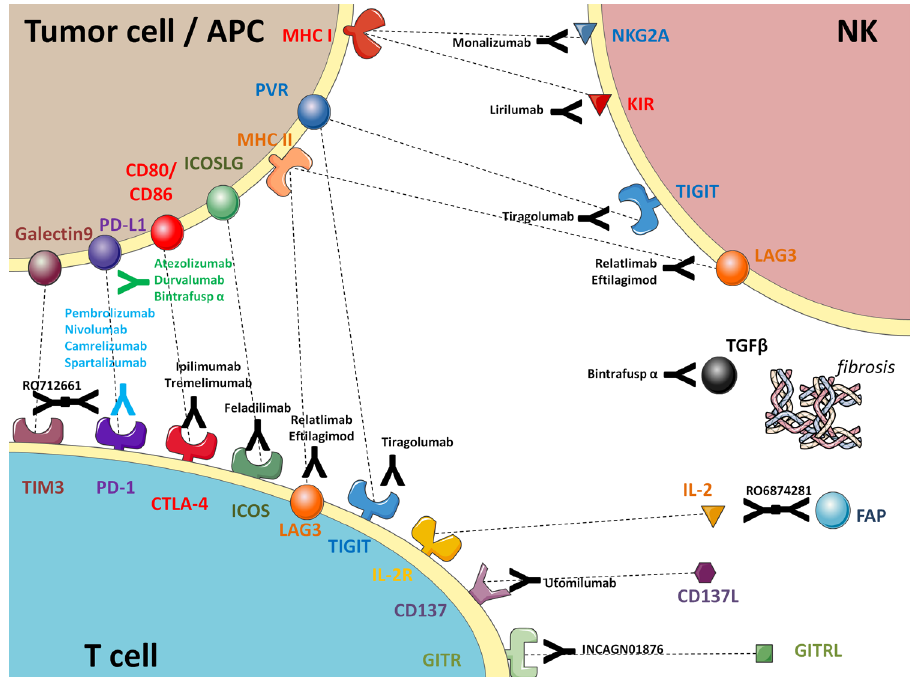
Figure 1. Schematic summary of approved and experimental immunotherapy agents in HNSCC (prepared using the open-access graphical repository of SMART-servier medical art). APC: antigen-presenting cell; MHC: major histocompatibility complex; PVR: poliovirus receptor; GITRL: the ligand for glucocorticoid-induced TNFR family-related protein; KIR: killer cell immunoglobulin-like receptors; IL2R: IL-2 receptors; ICOSLG: inducible T-cell costimulator